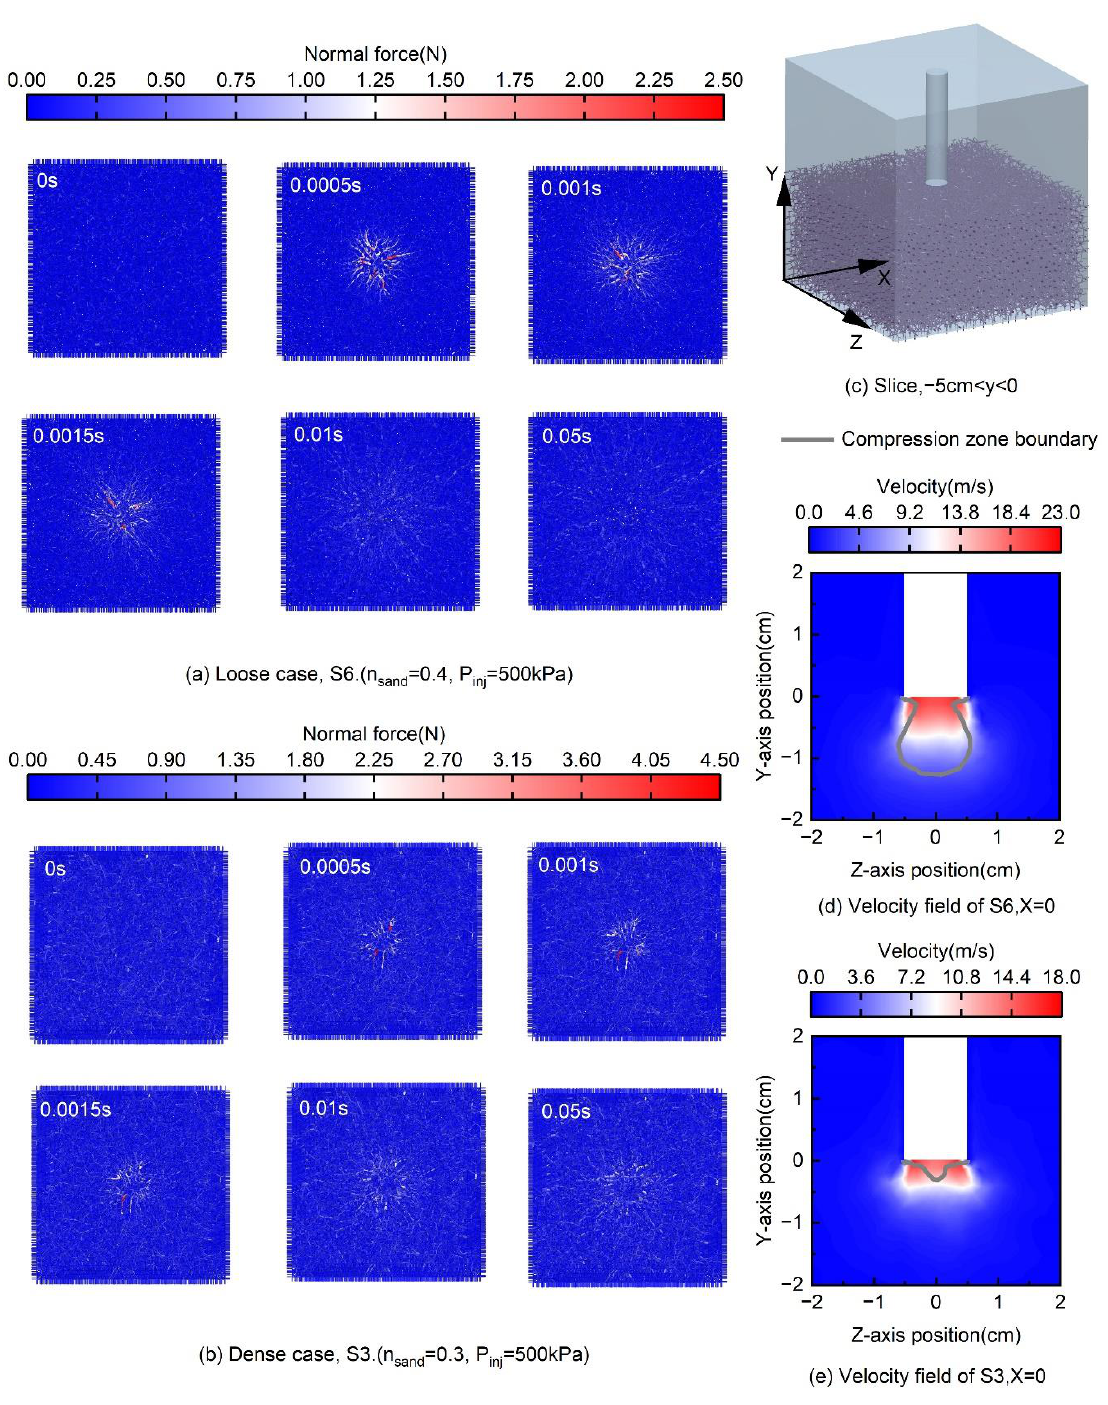
Figure 8. Contact forces and velocity field.